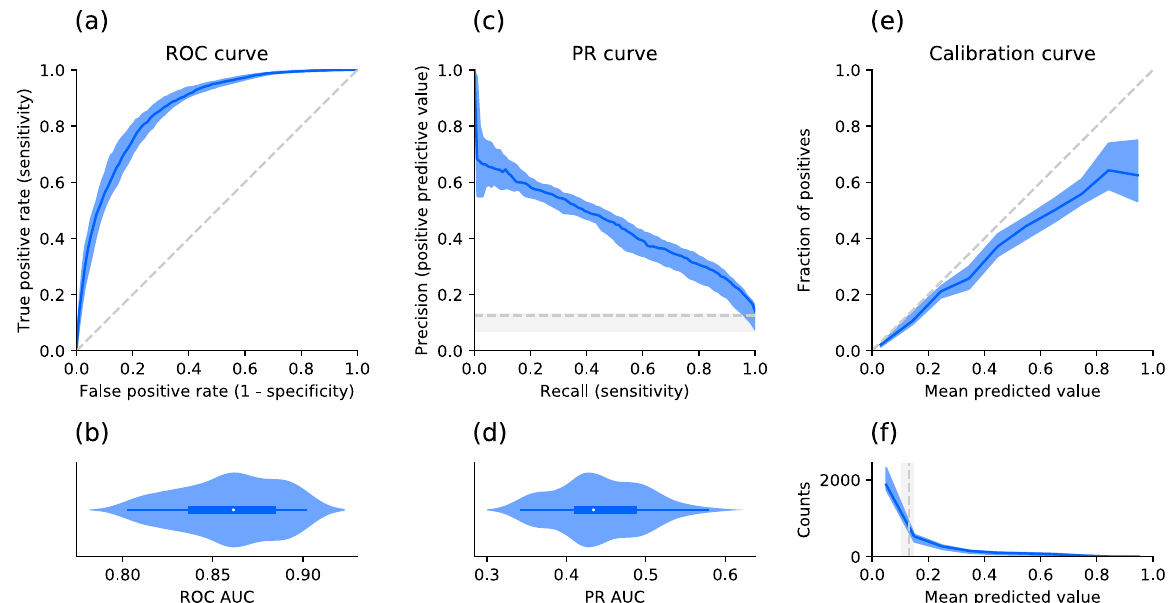
Fig. 4 Model performance and calibration for the reduced feature sets across splits. a Receiver operating characteristic (ROC) curve: Median and interquartile range (IQR) of the performance (blue) and chance level (no predictive value) as a reference (dashed gray line). b Corresponding normalized violin plot of the distribution of the ROC area under the curve (AUC). c Same representation for the precision recall (PR) curve and d corresponding distribution of the PR AUC. e Median and IQR (blue) of the fraction of actual positives (labeled as critical state) for the binned (10 bins) mean predicted values (i.e., probabilities). The reference diagonal represents perfect calibration (dashed gray line). f Median and IQR (blue) for the counts within each bin of mean predicted value. The vertical gray line shows the median and IQR for the optimal decision threshold based on the Youden ’ s J statistic.